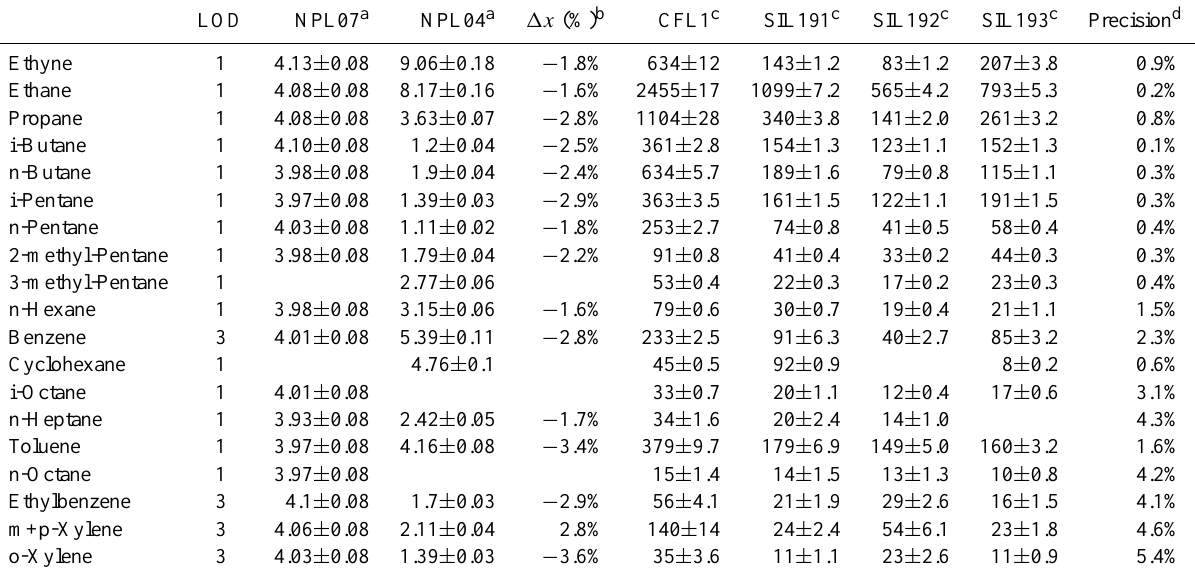
Table 2. Standards, limits of detection (LOD), and precision of the GC-FID system.